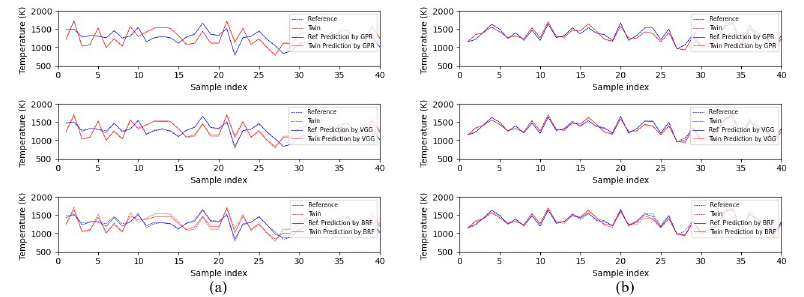
Fig 8. Examples of performances of the retrained models on spectral twins. In each figure, the top, middle and bottom subplots are the predictions of GPR, VGG and BRF, respectively. (a) First 40 twins with the biggest temperature difference at the similarity level of 10 − 3 . (b) First 40 twins with the biggest temperature difference at the similarity level of 10 − 3 .